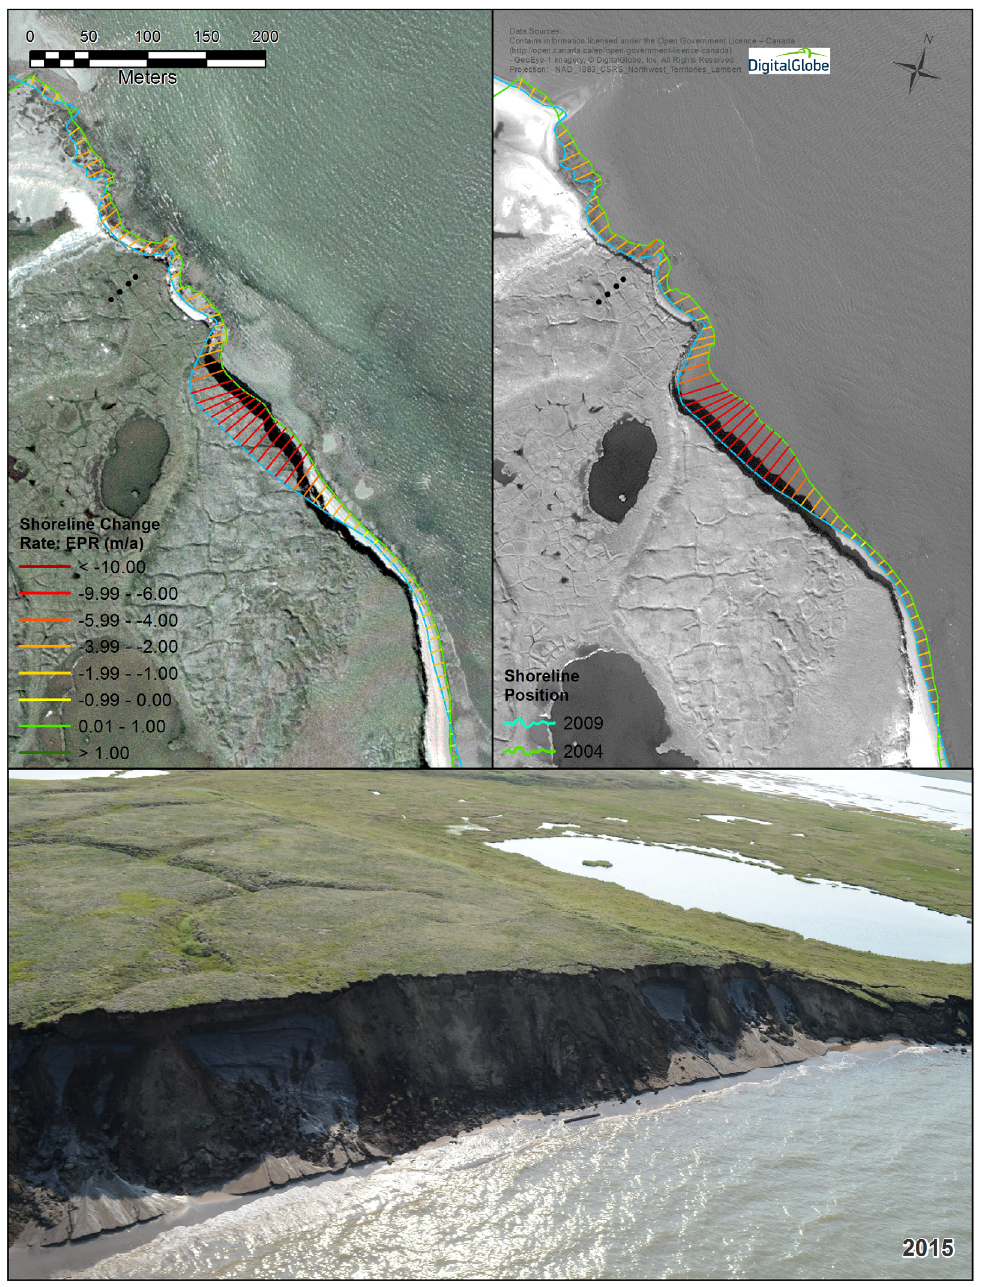
Fig. 10: Recent erosion rates at east Toker Point, showing higher rates associated with exposed ground